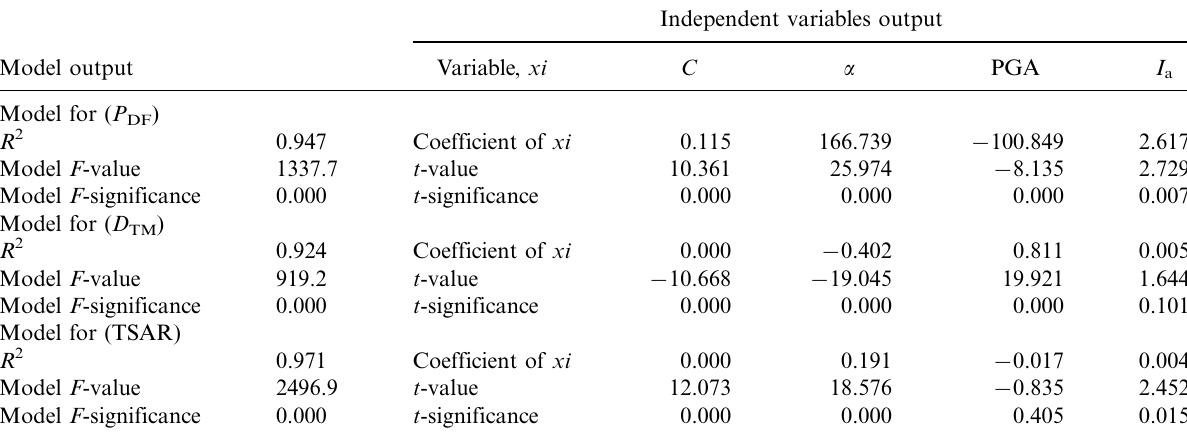
Table 8. Linear regression